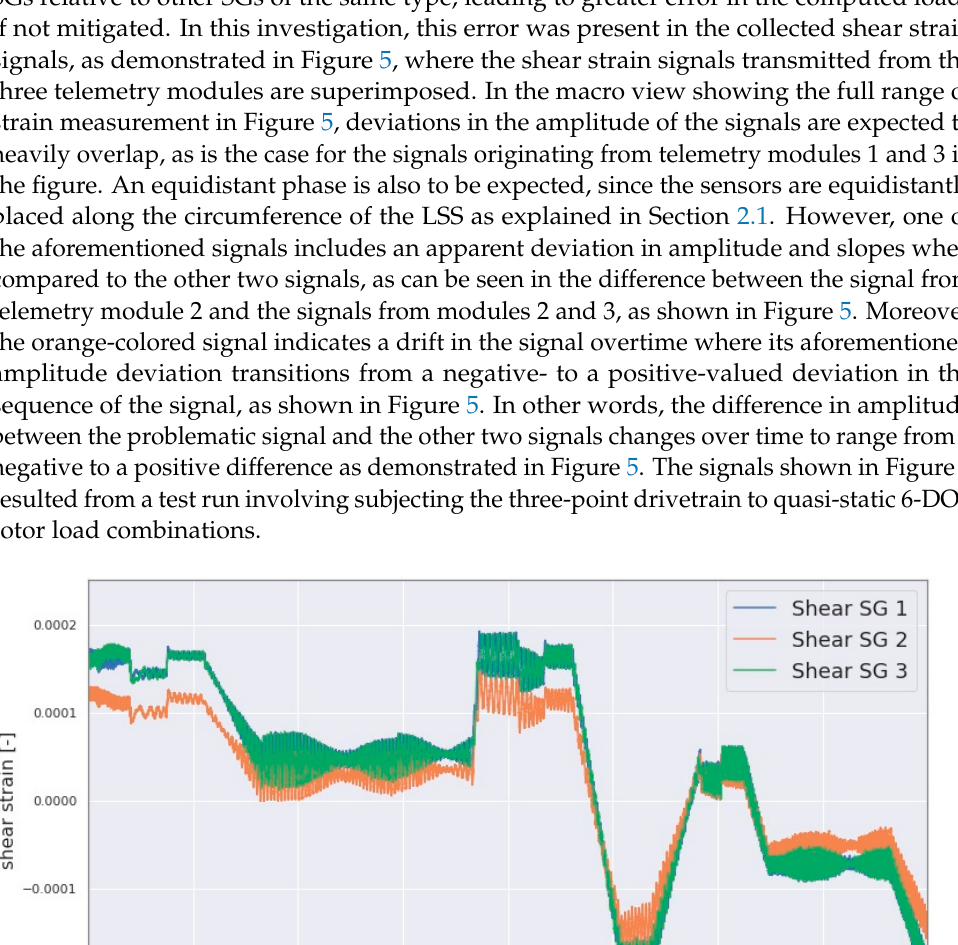
Algorithm 1 For mitigation of the error shown in Figure 5